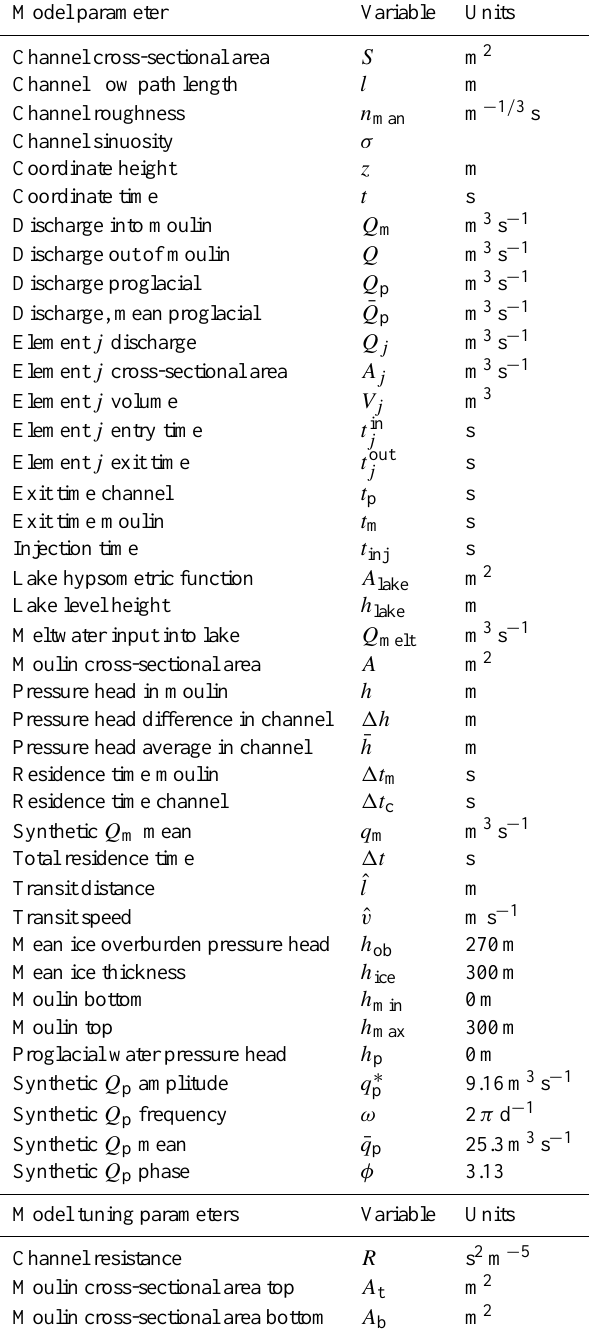
Table 2. Model constants and fitting parameters.